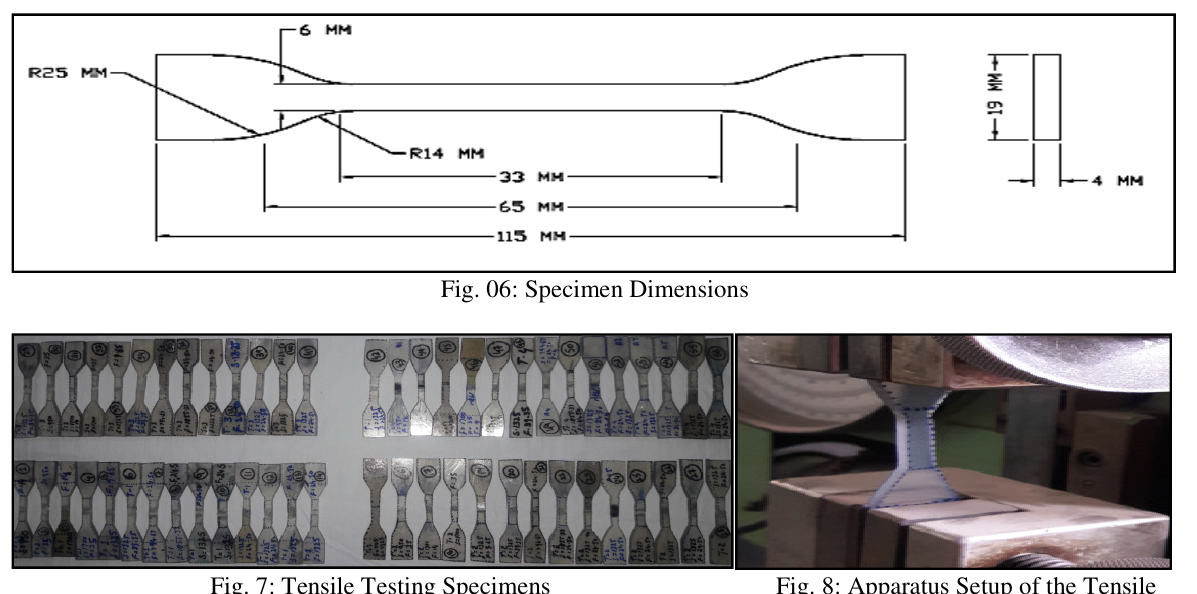
Testing Specimen